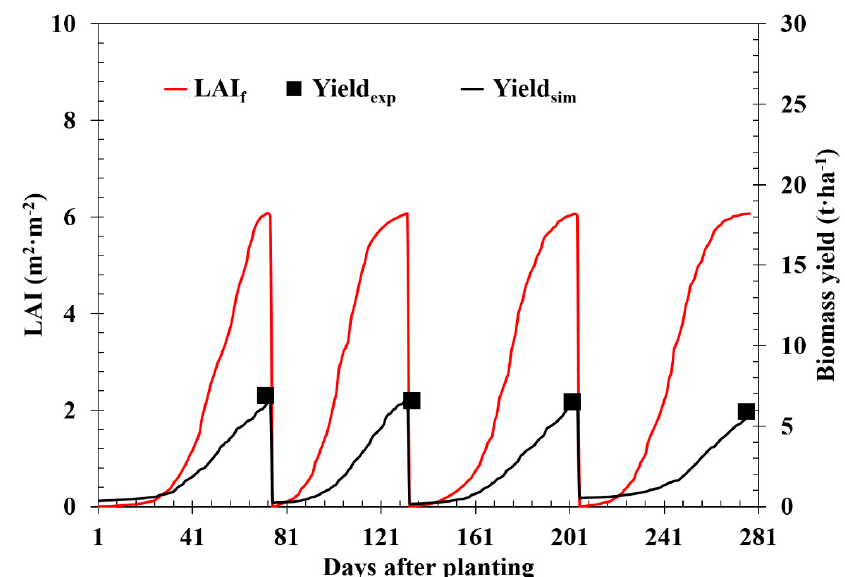
Figure 4. Simulation results for the LAI development (red line) of Napier grass with calibrated parameters, and the comparison of experimental yield at harvest (black squares) and simulated yield (black line) at Sukhothai plantation from May 2001 to April 2002 [43]. Table 4. Mean simulated and observed Napier grass DMY values in t · ha − 1 according to crop site treatments and statistical analysis results (RMSE, ME, and R 2